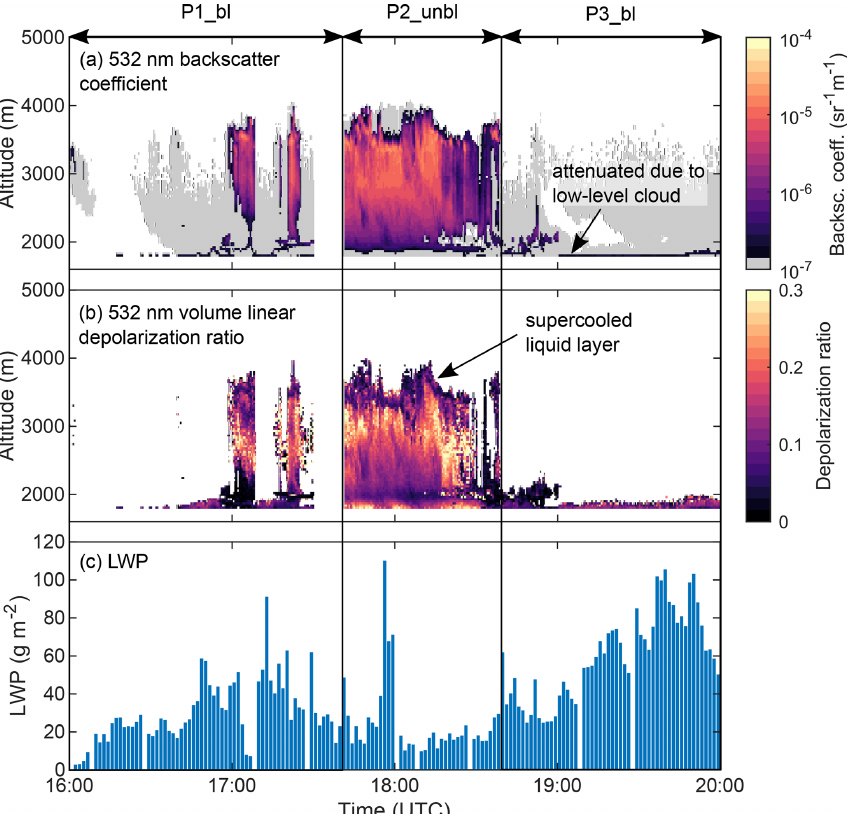
Figure 4. Observations of the (lidar) attenuated backscatter coefficient (a) , the lidar linear depolarization ratio (b) and the liquid water path measured by the microwave radiometer (c) . The measurement period is divided into three periods, where P1_bl and P3_bl indicate blocked low-level flow, and P2_unbl indicates unblocked low-level flow (see Sect. 4.1 for more